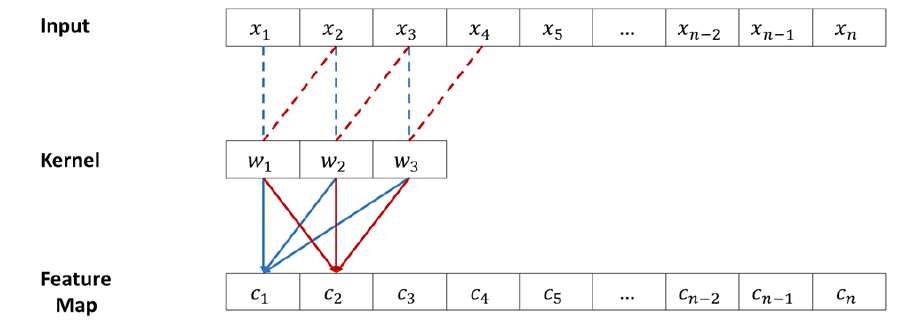
Figure 9. Illustration of one-dimensional convolution filter operation.